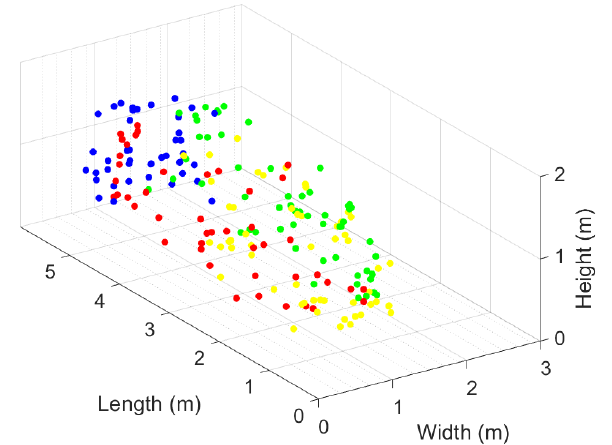
Figure 19. 3D points of the back side (blue), front side (yellow), left side (red), and right side (green) of the car.